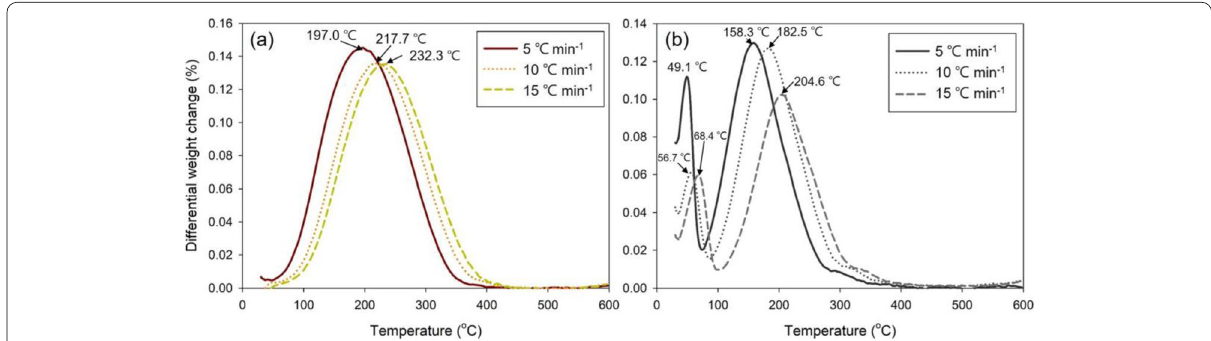
Fig. 7 DTG curves for a TOL‑KBAC and b MEK‑KBAC under heating rates of 5, 10, and 15 °C min − 1